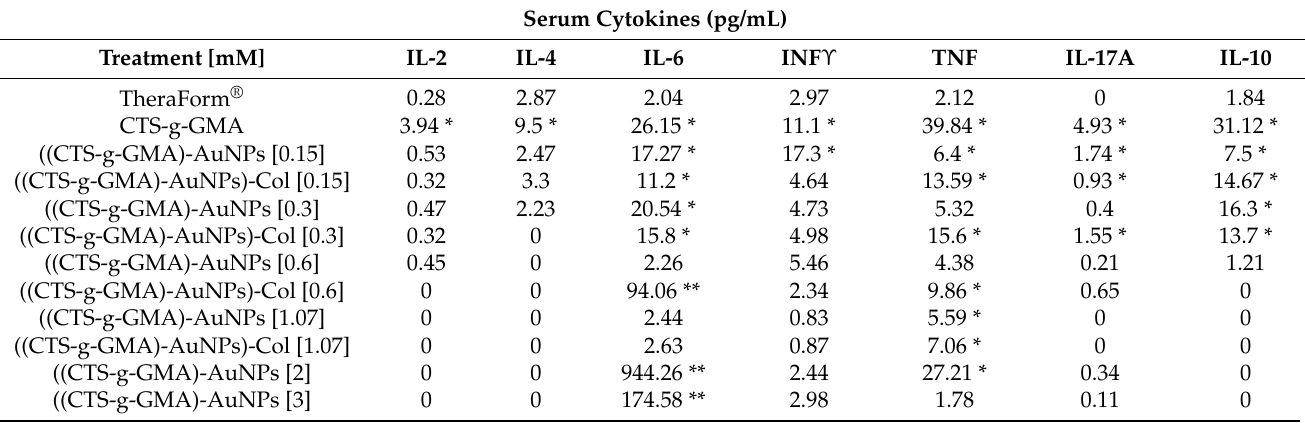
Table 2. Induction of serum cytokines due to exposition with Au nanocomposites and collagen. Serum Cytokines (pg/mL)